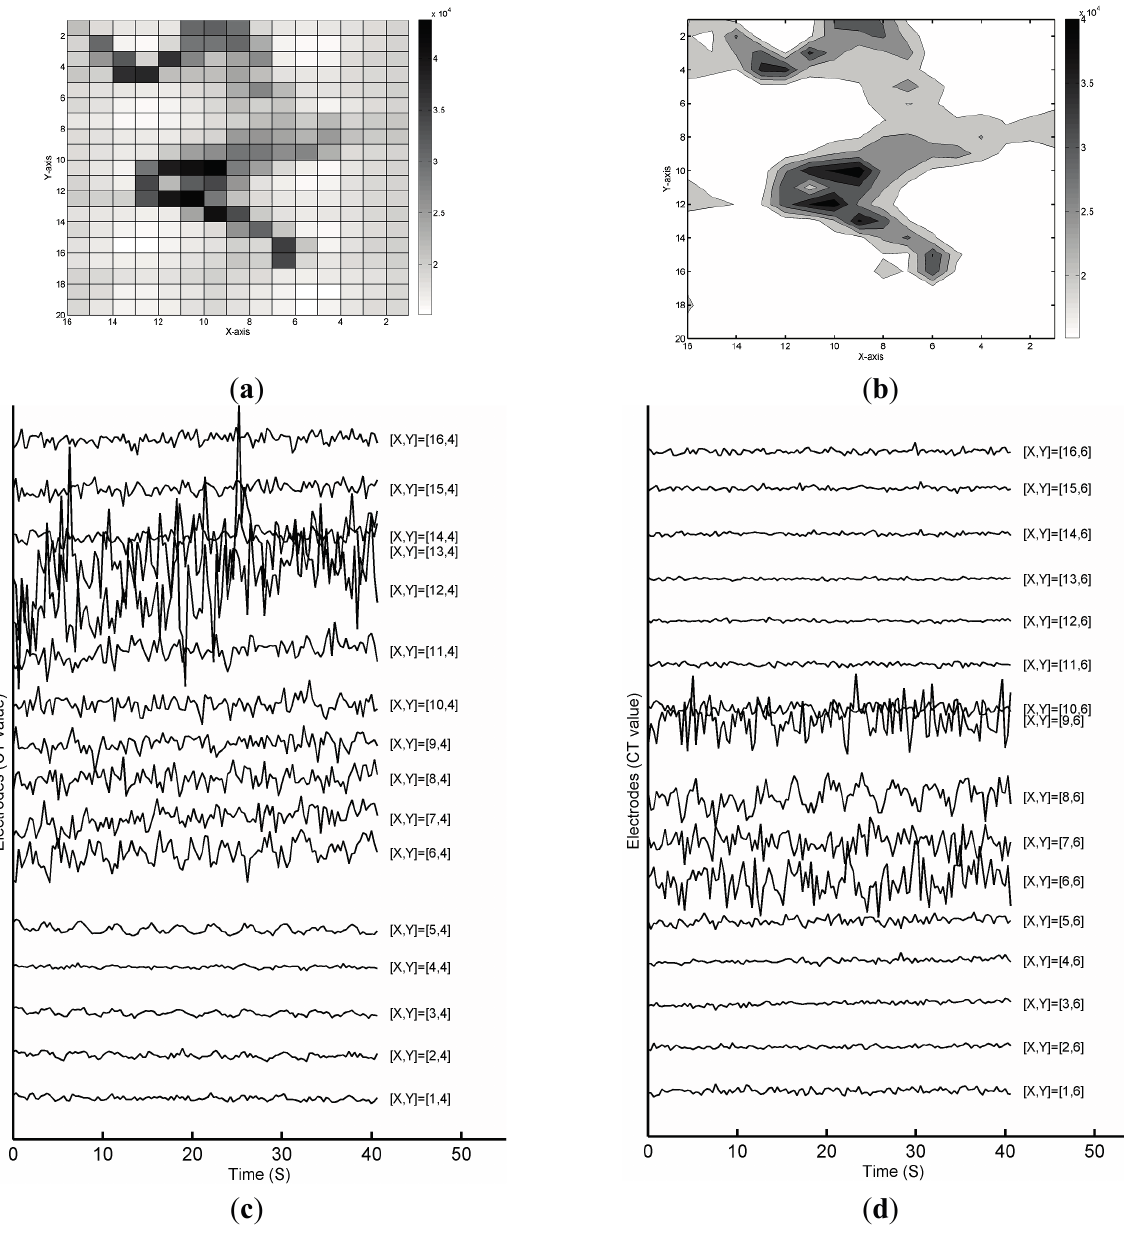
Figure 5. ( a ) Raw data from electrodes showing subject in sleep posture; ( b ) Contour map; ( c ) Variation of raw electrode data from the fourth row; ( d ) Variation of raw electrode data from the sixth